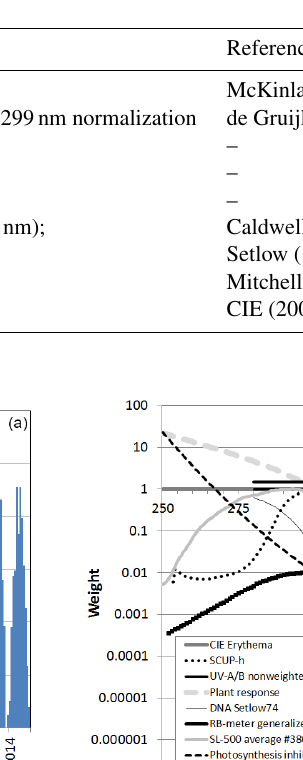
Table 2. Action spectra used routinely in the processing to derive weighted dose rates from Brewer UV measurements.